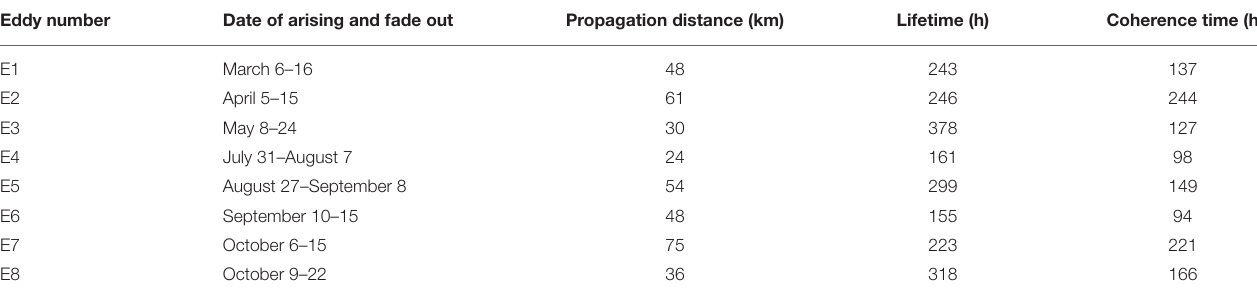
TABLE 1 | Selected eddies in the Western Baltic Sea between March 1, 2010 and October 31, 2010 detected with the eddy tracking tool based on M V . Eddy number Date of arising and fade out Propagation distance